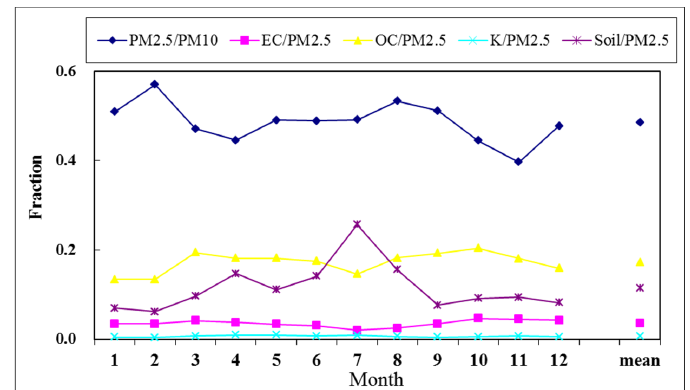
Figure 5. The monthly average of fire indicators at the WIMO1 site.